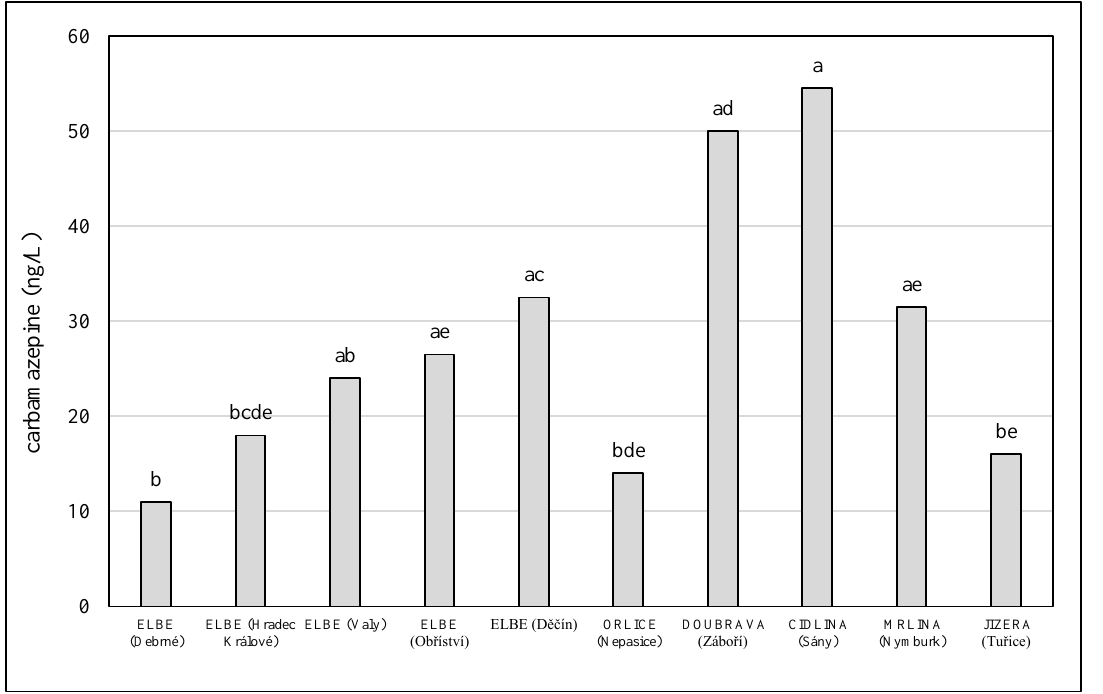
Figure 9. Median values of gabapentin-lactam concentration at the sampled locations during the year 2021. Significant differences among the localities are indicated by different alphabetical super- scripts ( p < 0.05).